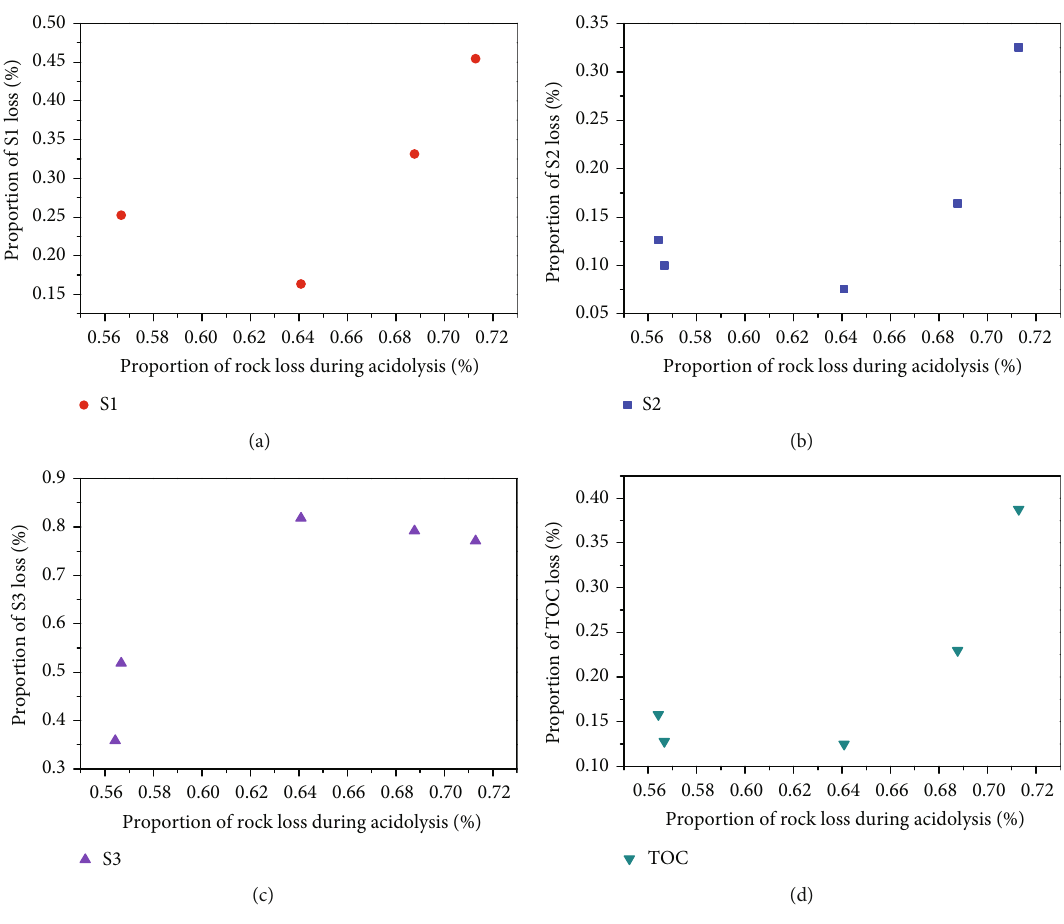
Figure 9: Relationships of proportion of rock loss during acidolysis and proportion of S1(a), S2(b), S3(c), and TOC (d) loss for samples from Cretaceous Eagle Ford Formation in Texas, USA.